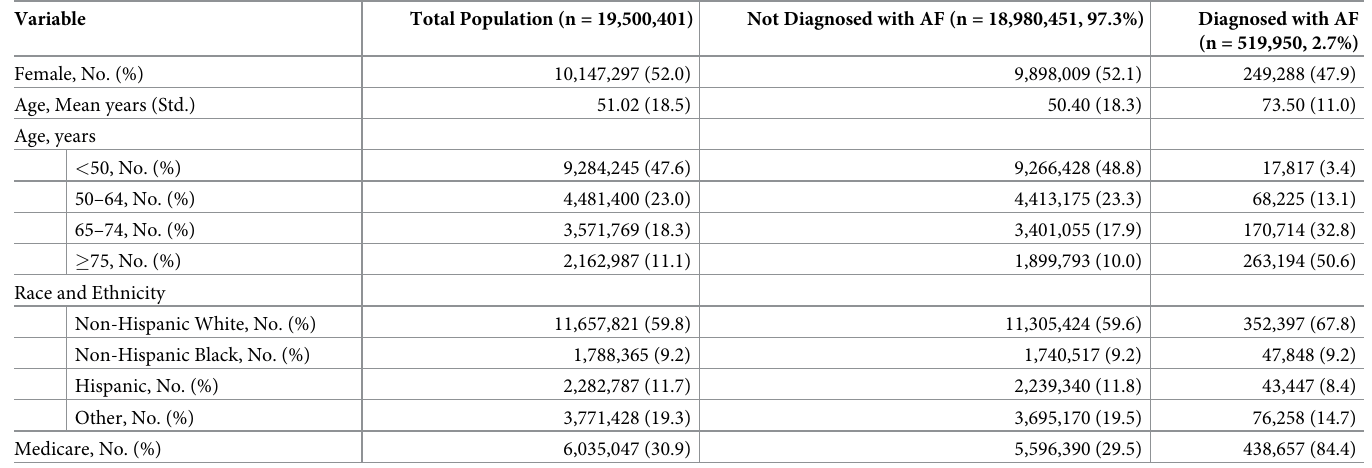
Table 1. Baseline patient